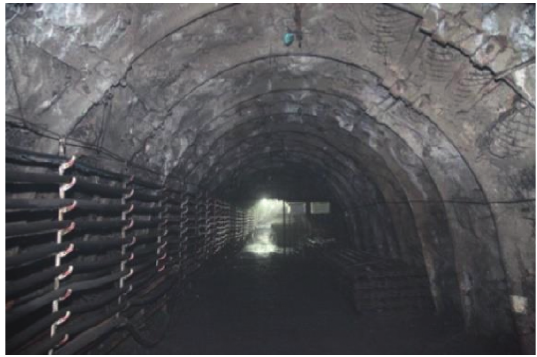
Figure 14: Service effect of the 1411 tail